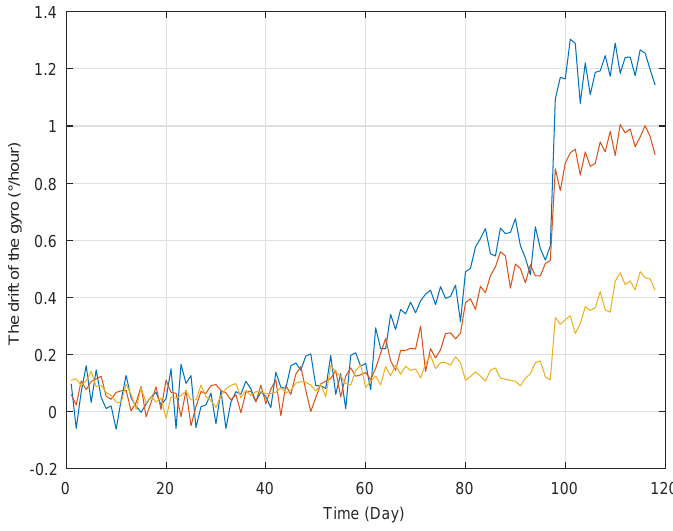
Figure 1. The degradation trajectories of the